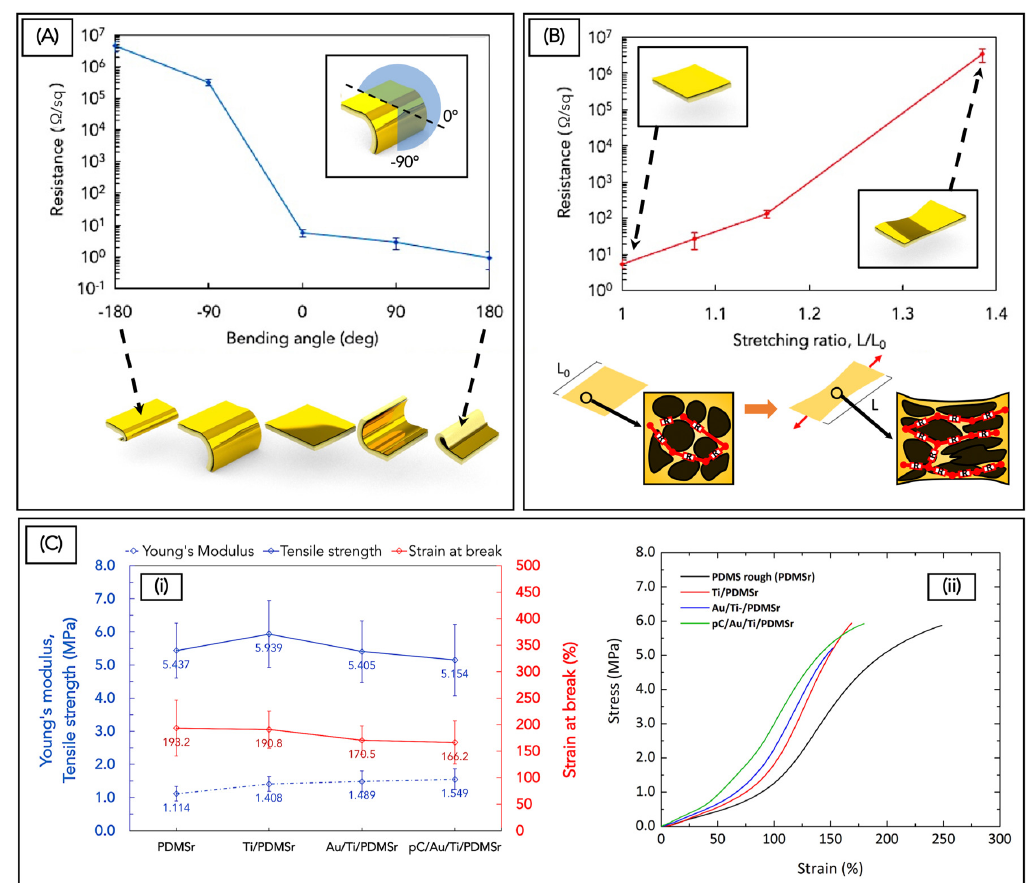
Figure 3. ( A ) Measurement of electrical resistance of the metallized PDMS patch as a function of the bending angle. ( B ) Measurement of electrical resistance of the metallized PDMS patch as a function of the stretching ratio; the insets show the conductive pathways inside the porous morphology of the patch. ( C ) Dynamic mechanical analysis (DMA) of the PDMS rough patch with the overlying layers. (i) Summary plot of the Young’s modulus, tensile strength, and strain at break of neat rough PDMS (PDMSr) and covered with Ti, Au / Ti, and pC / Au / Ti. (ii) Stress–strain curves obtained after the tensile tests of the same samples.